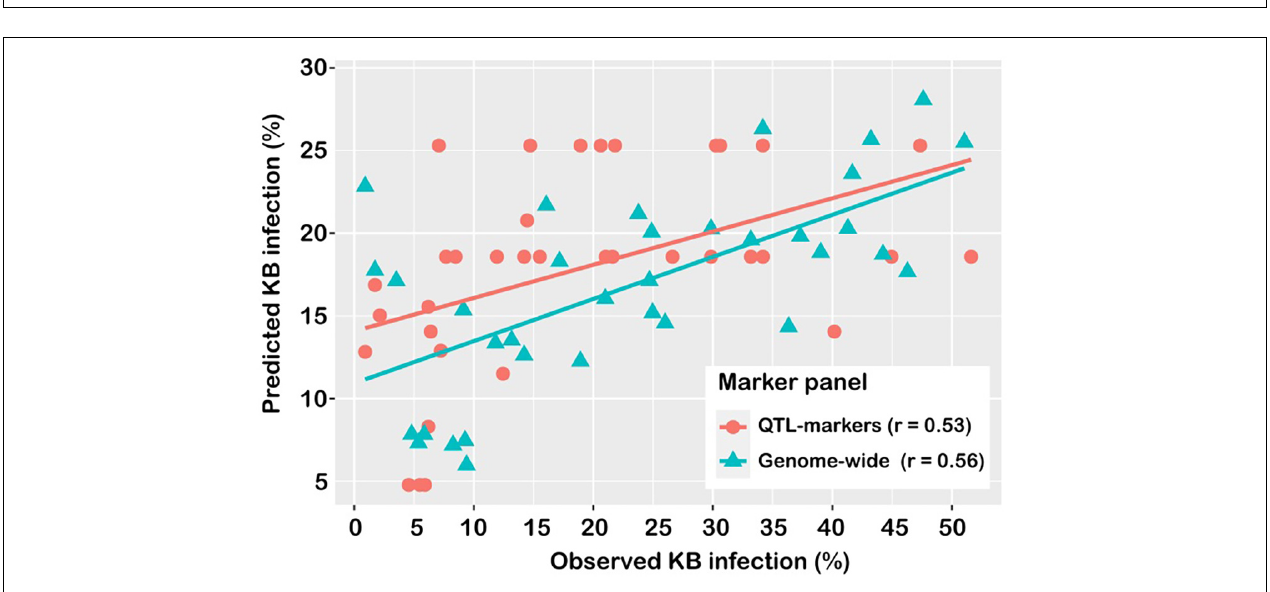
FIGURE 4 | Prediction accuracy of models for Karnal bunt resistance, using markers detected in GWAS analysis (QTL), and genome-wide markers (WG).